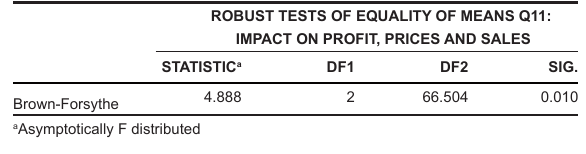
TABLE 22 Test of homogeneity of variances (question 11)